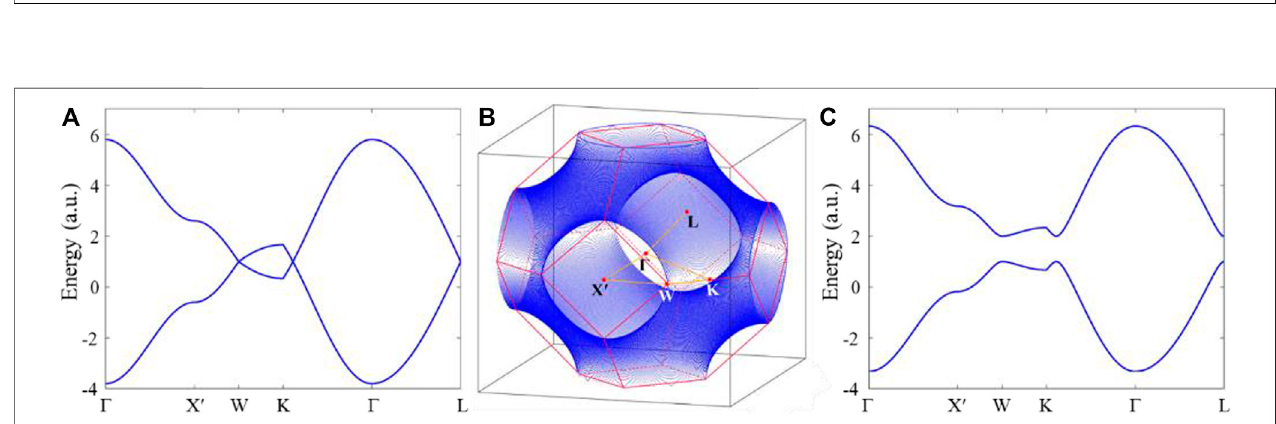
FIGURE2| Bulk bandstructuresviaTBA. (A) Band structures with m 1 (cid:1) m 2 (cid:1) 1, t (cid:1) 0.8 (B) A3Dviewofnodal planein the3DBZ. (C) Complete bandgap caseof the NaCl-like AC when m 2 (cid:1) 2.